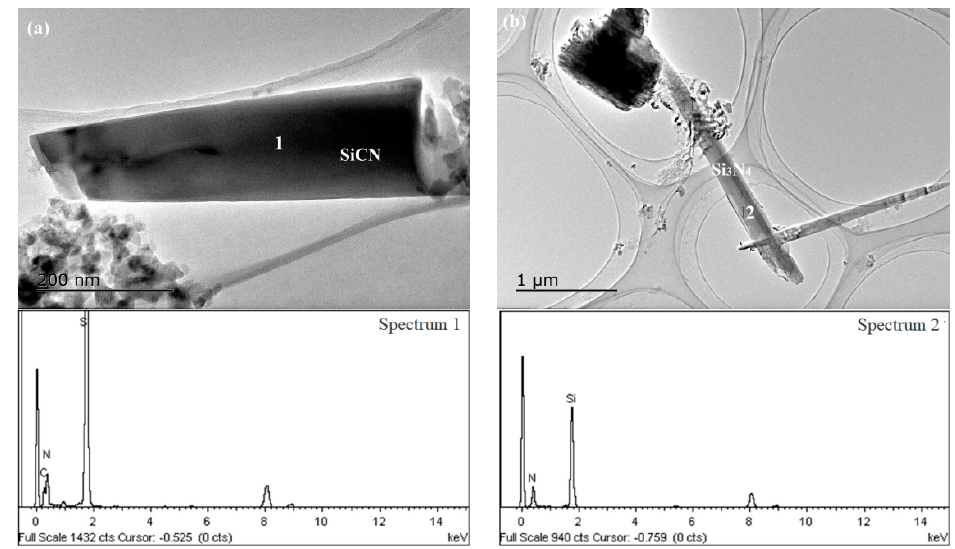
Figure 14. TEM images and EDS patterns of sample B synthesized at 1550 °C (Si:C = 1:1): ( a ) SiCN and ( b ) Si 3 N 4.